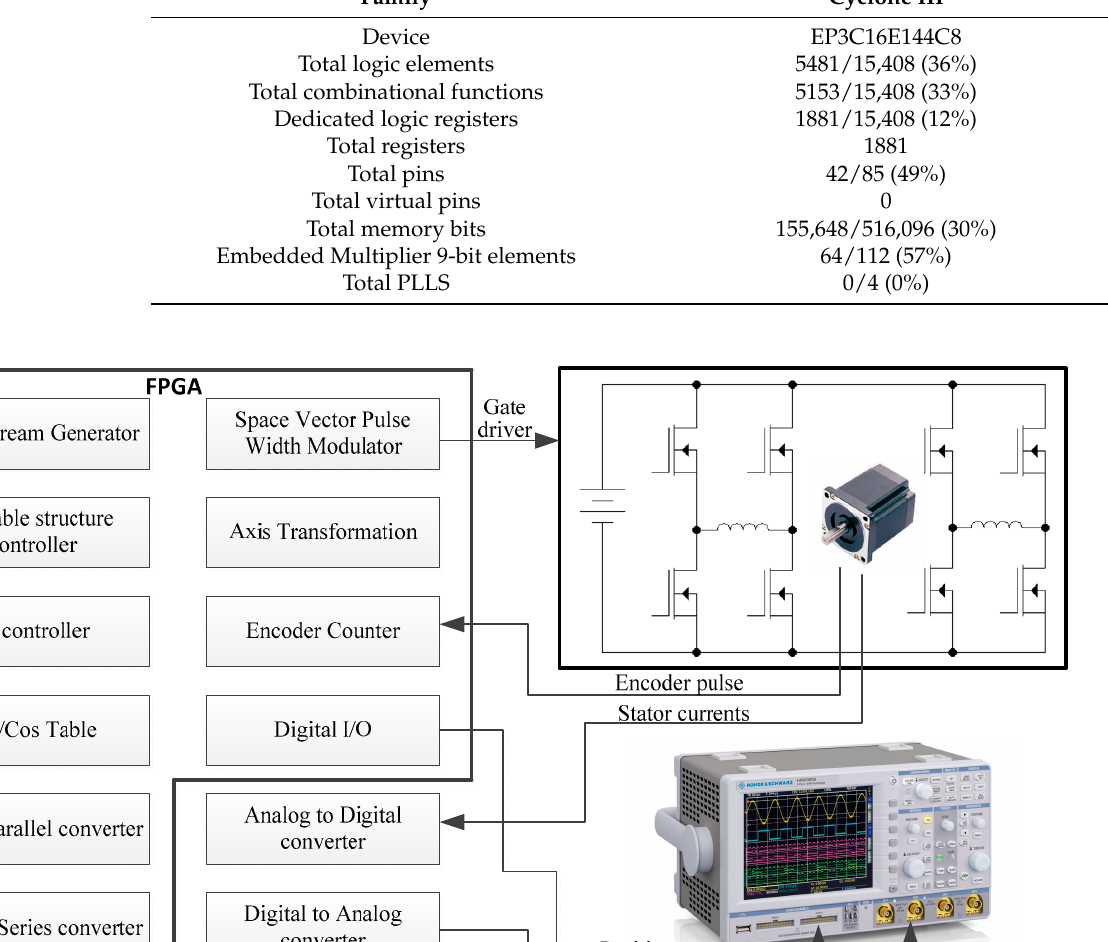
Figure 17. The experimental responses of position and speed response with step command input.